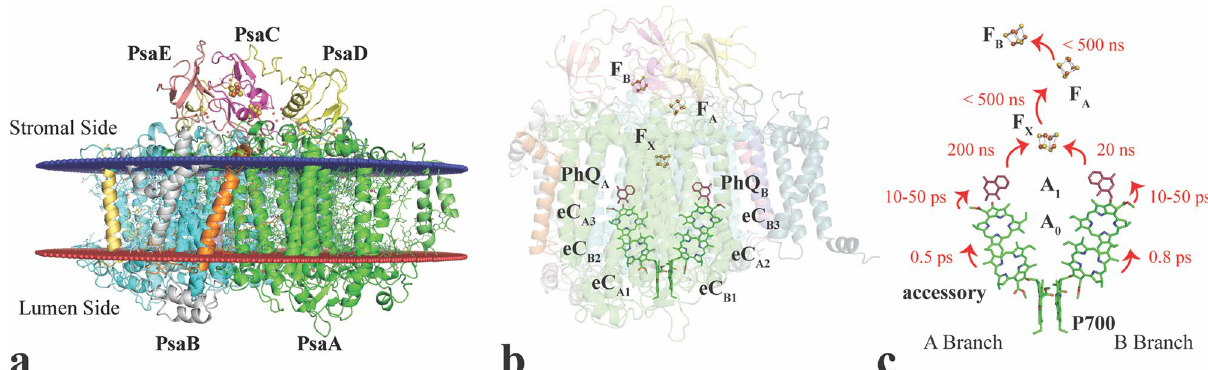
Figure 1. Overview of PS I. ( a ) Membrane plane view of one monomer of PS I with multiple subunits represented in different colors. The two main subunits PsaA and PsaB and the three membrane extrinsic subunits PsaD, PsaC, and PsaE are labeled. Many of the trans-membrane helices are visible between the membrane planes (red and blue planes). Membrane orientation generated via the PPM server (https:// opm. phar. umich. edu/ ppm_ server). ( b ) View of the reaction center part of PS I. The cofactors involved in electron transfer are arranged in two pseudo-symmetrical branches comprised of Chl eC A1 , eC B2 , eC A3 and PhQ A on one side and Chl eC B1 , eC A2 , eC B3 and PhQ B on the other side. Both branches connect at the [4Fe4S] cluster F X at the stromal side, with